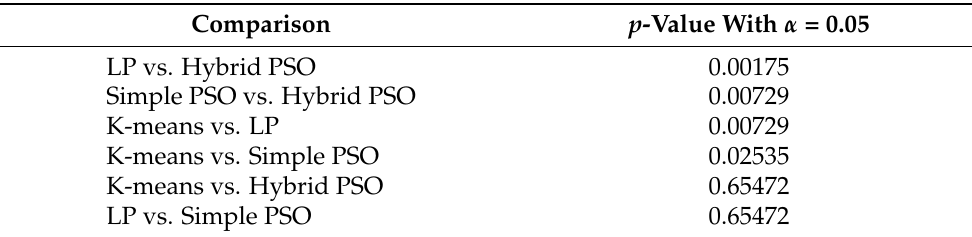
Table 22. The results from the Friedman test: the comparison between each metaheuristic using the arithmetic means of the silhouette